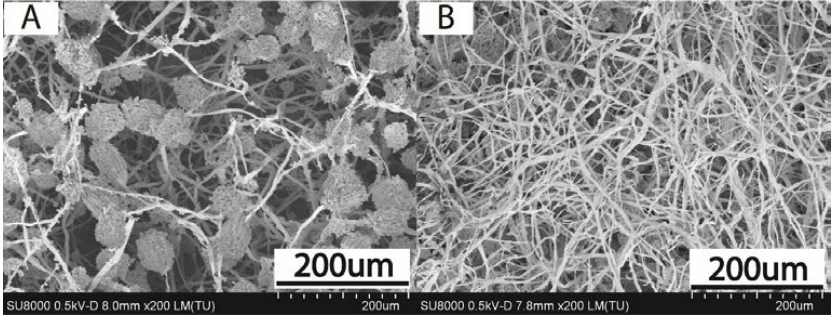
Figure 3. The characterization of A. apis by SEM image. ( A ) The control culture, ( B ) The culture treated with 3 mg/L of peroxide 6 .